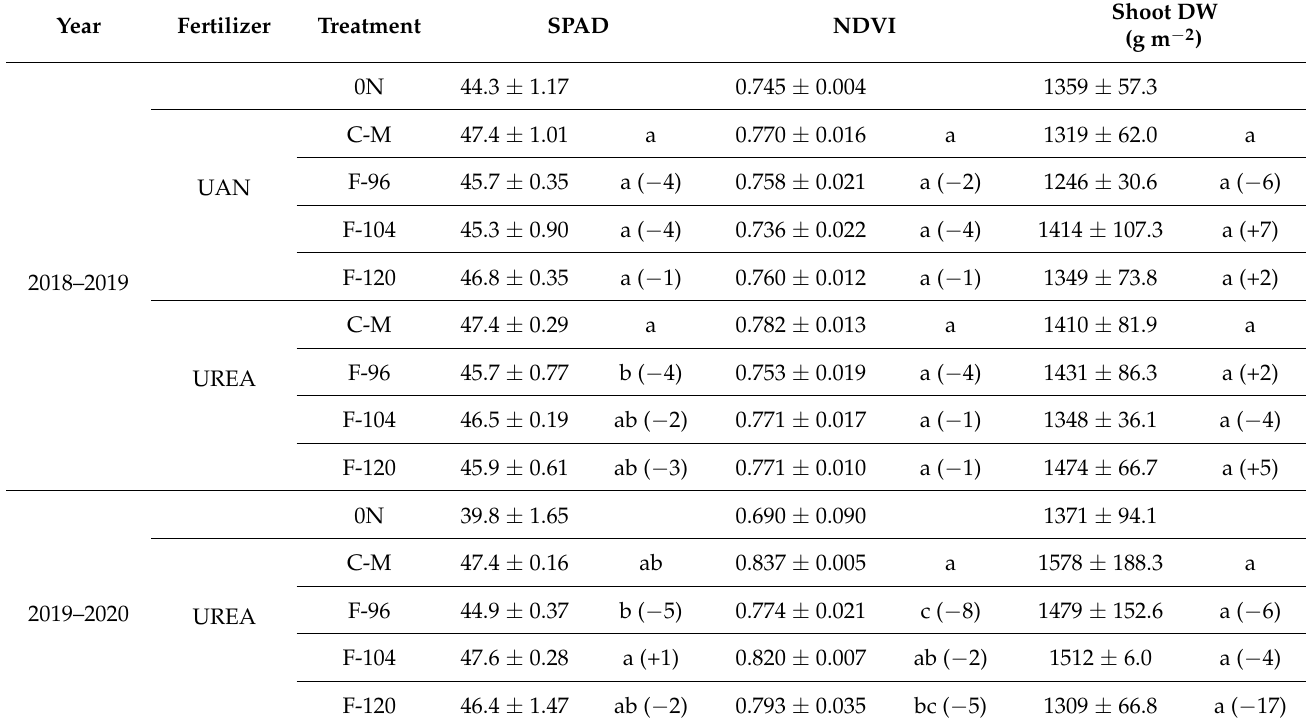
Table 2. Vegetational parameters: SPAD, NDVI (mean seasonal values from stem elongation to end flowering) and